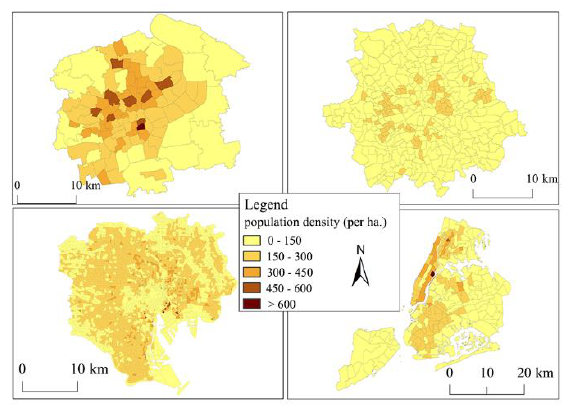
Figure 1. The population density of the four study areas